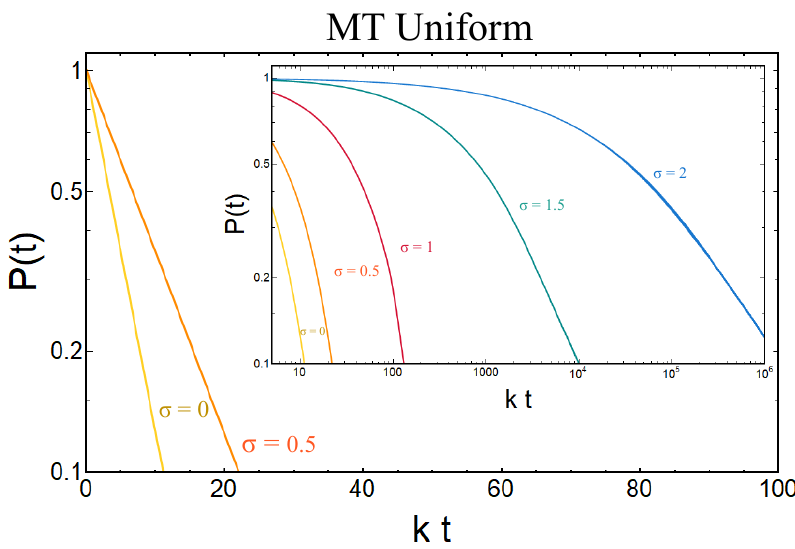
Figure 10. (Color online) Main: Log-linear plot of the polarization decay function for low disorder (curves are exponential or nearly exponential). Inset: Log-log plot of polarization decay for various disorder constants, σ , in MT using constant local field magnitudes. For σ > 1, at long times, the decay is algebraic; the dependence agrees well with the trend ∼ t − 1/ σ . Additional parameters used in simulations are γ = 0.025. For σ = 0, k = 1, while for σ > 0, k =